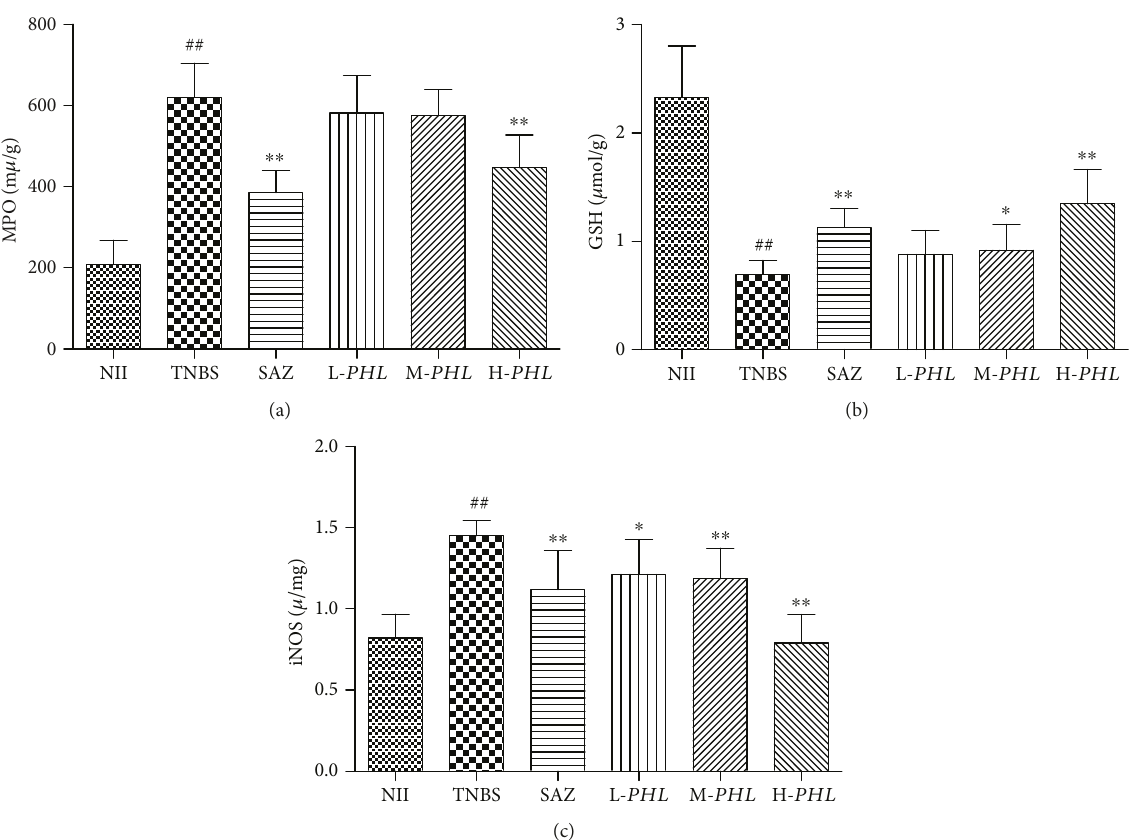
Figure 3: E ff ects of PHL extract (125, 250, and 500 mg/kg) and SAZ (120mg/kg) on the colonic MPO activity (a), GSH content (b), and iNOS activity (c) in rats with TNBS-induced experimental intestinal in fl ammation. Data are expressed as means ± SD ( n = 8 ); ∗∗ P < 0 01 and ∗ P < 0 05 versus TNBS; ## P < 0 01 versus